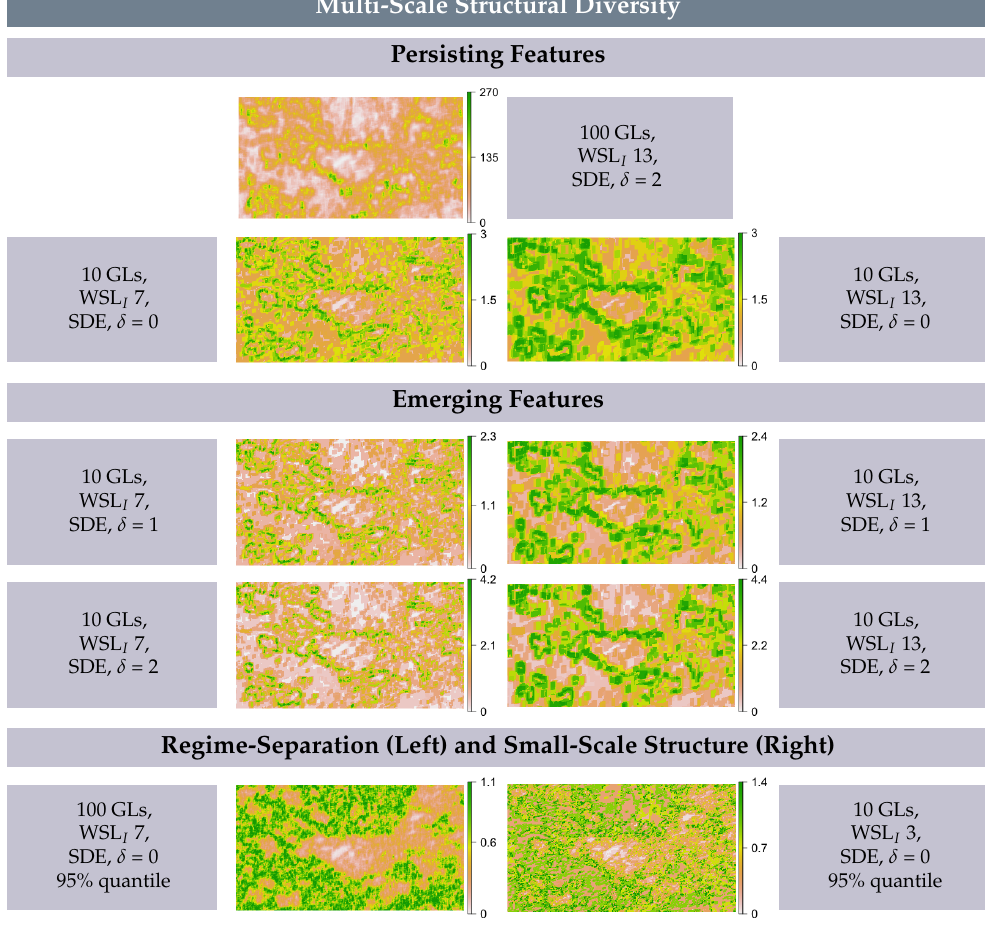
Figure 4. Structural diversity entropy (SDE), quantified wit δ ∈ { 0,1,2 } , the outer scale is D in all cases. Minimum values displayed are set to